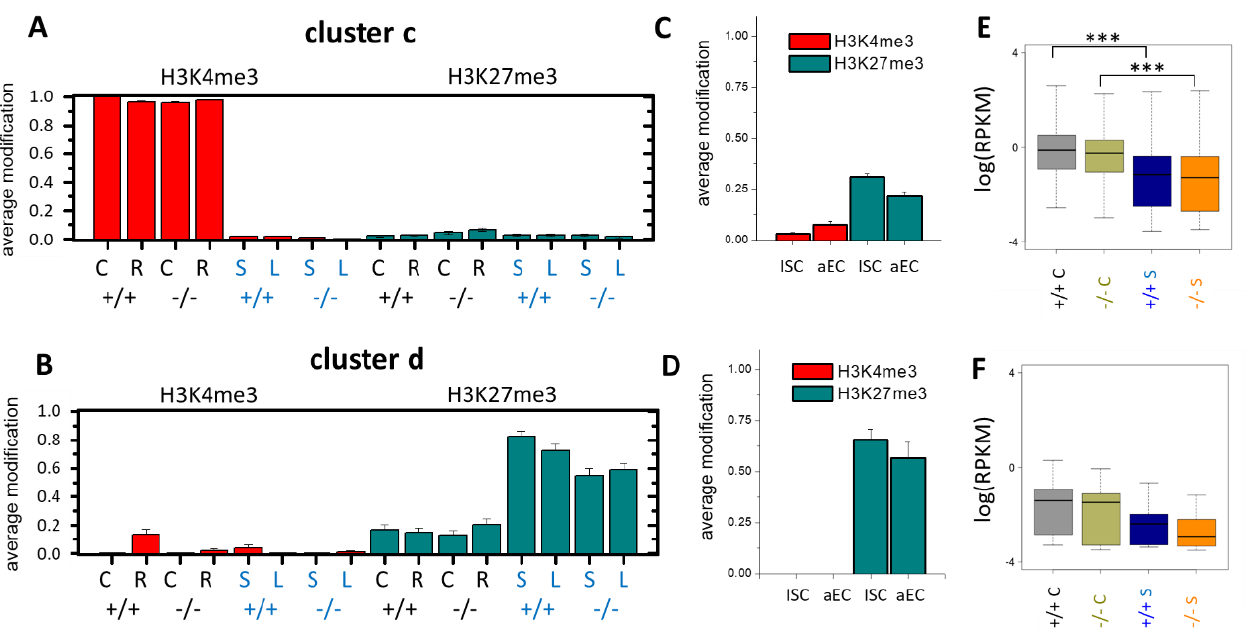
Figure 3. Epigenetic repression of the cluster c and d genes. Samples: Msh2 +/+ : +/+, Msh2 − / − : − / − ; black letters: tissue, C = control, R = irradiated, blue letters: organoids, S = short-term and L = long-term culture (error: se). ( A ) Cluster c comprises 401 genes in state (10) in all tissue samples that lose H3K4me3 in all organoid samples (00). The fraction of genes associated with the modification is shown. ( B ) Cluster d comprises 102 genes in state (00) in all tissue samples that gain H3K27me3 in all organoid samples (01). ( C , D ) In isolated ISCs and aECs (Kazakevych et al., 2017), genes of both clusters show the modification state of the organoids (error: se). ( E , F ) The changes in the organoids are expected to induce gene repression. A significant change is seen for cluster c only. Box plots include expression data of all genes of the clusters in the 3 tissue and 3 short-term organoid samples; *** p -value < 0.001 ( t -test).